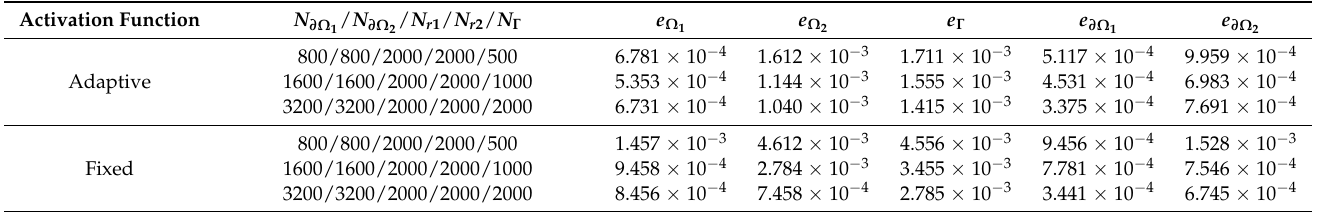
Table 9. Comparison of errors by adaptive and fixed activation function strategies with different numbers of training points for Example 5.